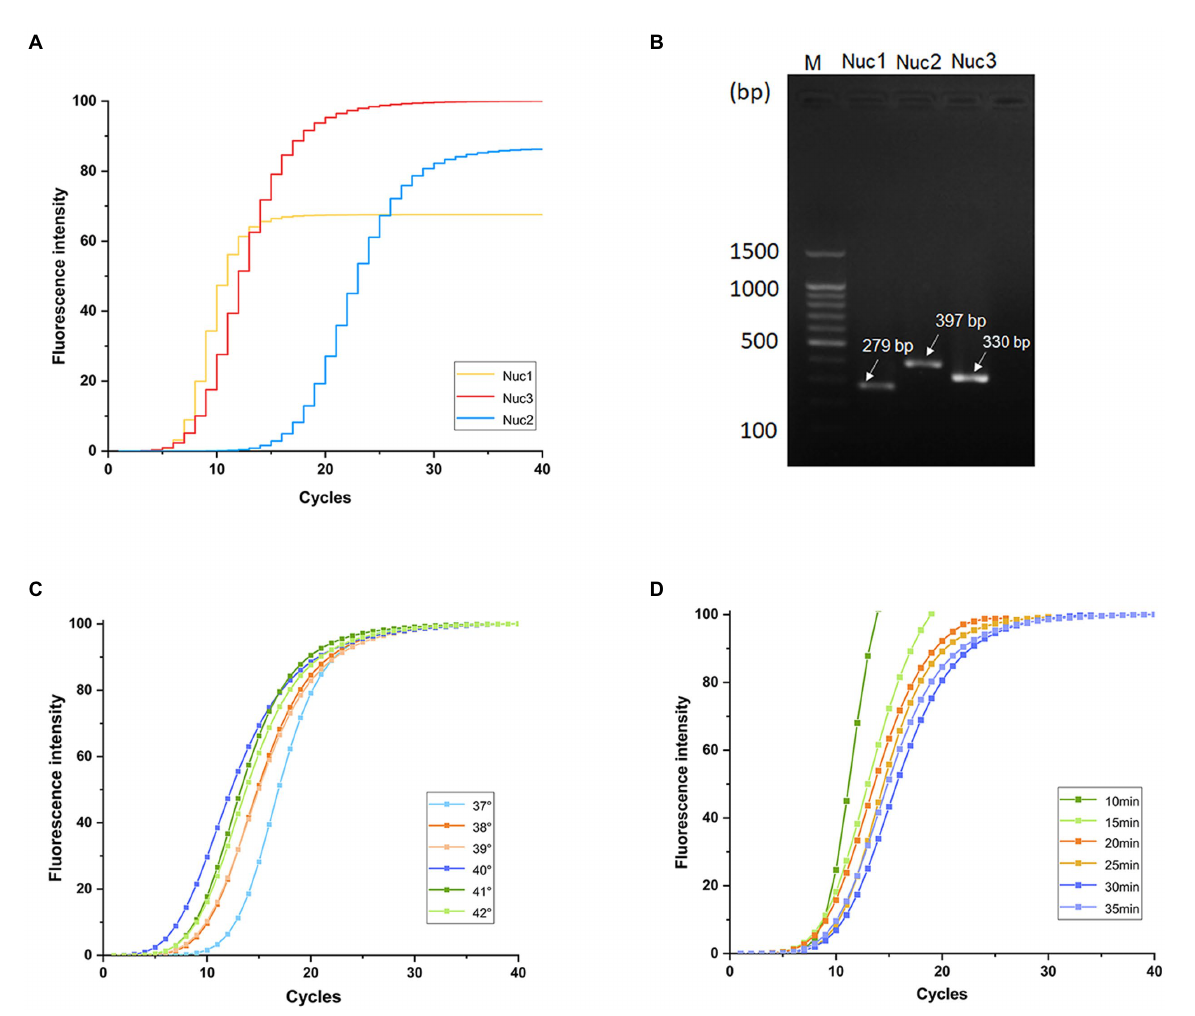
FIGURE 1 Primer screening and optimization of MIRA temperature and time. (A) Fluorescence intensity values of three pairs of primers. (B) Band diagram of three pairs of primers agarose gel electrophoresis analysis results. Optimization of MIRA reactions at different temperatures (C) and times (D)